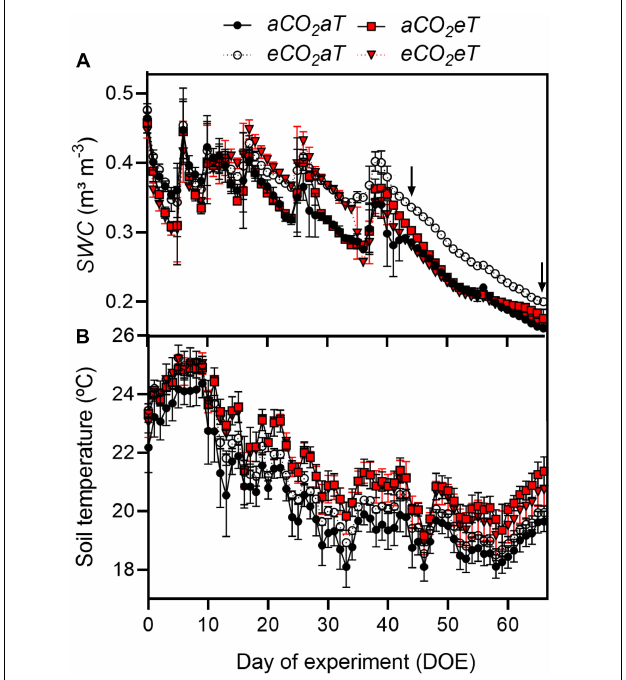
FIGURE 2 | (A) Daily average of soil water content ( SWC ) and (B) daily average of soil temperature under all treatments during the entire experimental period. Arrows indicate dates in which the leaf gas exchange parameters were measured. Treatments: aCO 2 aT (ambient [CO 2 ] and ambient temperature), eCO 2 aT (elevated [CO 2 ] and ambient temperature), aCO 2 eT (ambient [CO 2 ] and elevated temperature) and eCO 2 eT (elevated [CO 2 ] and elevated temperature). DOE = day of experiment. Stack bars indicate the standard